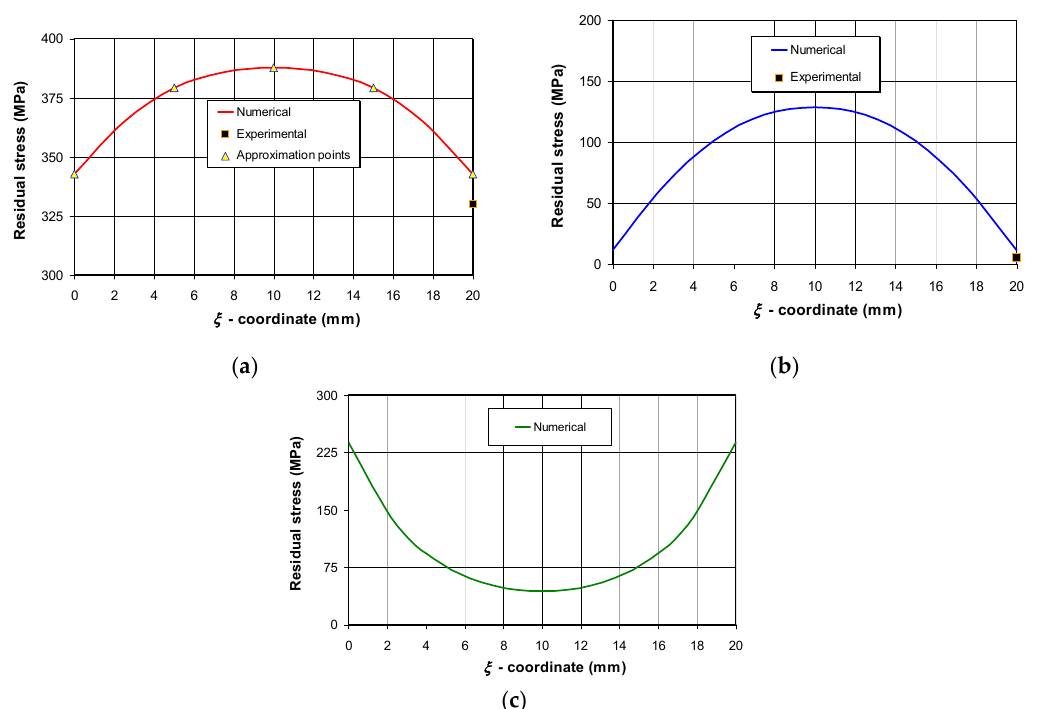
Figure 2. Through-thickness residual stress profiles in the center of the plate: ( a ) longitudinal stress, ( b ) transversal stress, ( c ) transversal stress at the distance of 22 mm from the weld line.